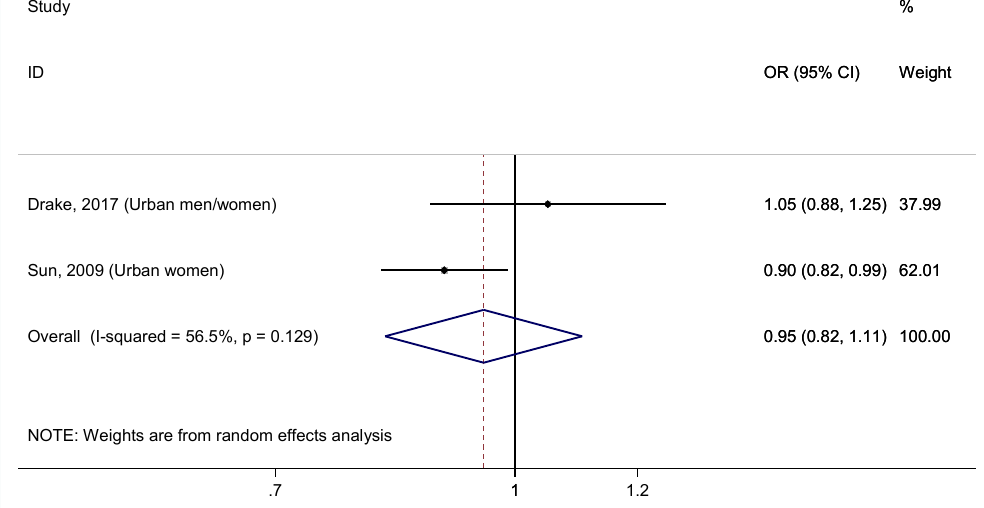
Figure 8. Forest plot of pooled effect size of the highest vs. lowest total zinc intake for T2DM. Squares represent ORs for each study, and the size of the square is the study-specific statistical weight. Horizontal lines indicate the 95% CI of each study. Diamond represents the combined OR estimate with corresponding 95%